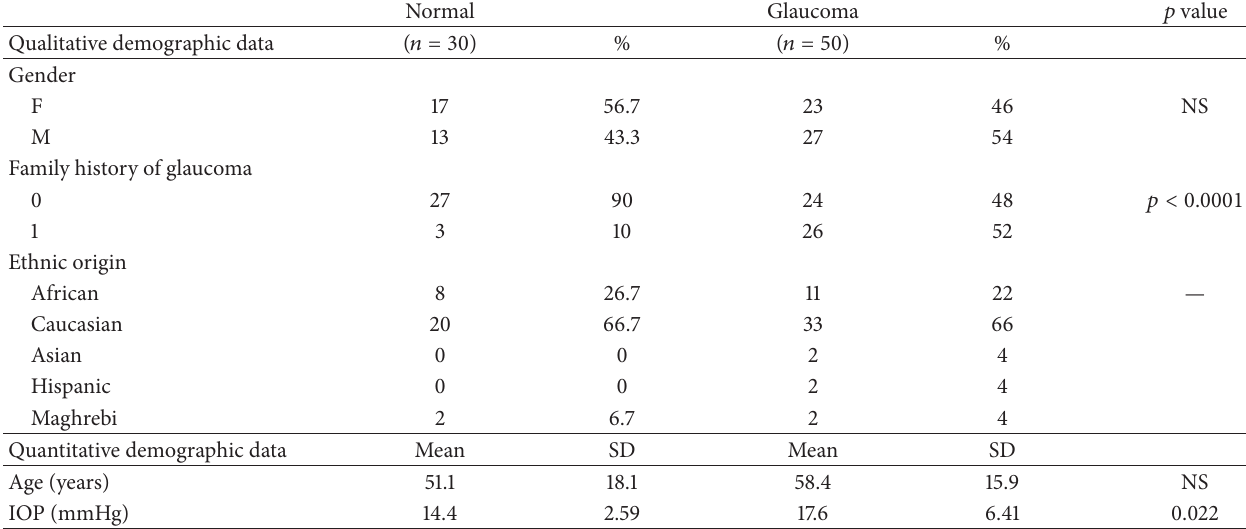
Table 1: Qualitative and quantitative demographic data. IOP: intraocular pressure; F: female, M: male. Normal Glaucoma